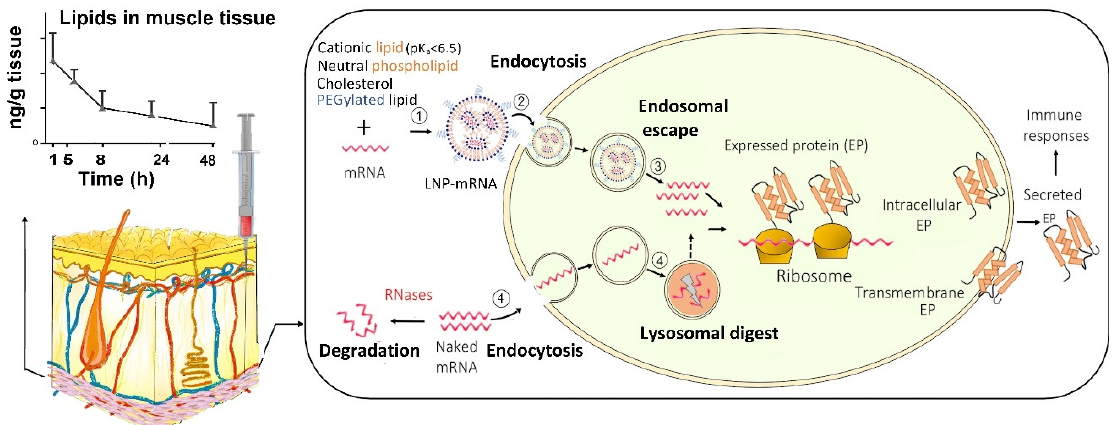
Figure 1. Uptake of mRNA-loaded lipid nanoparticles (LNPs) following intramuscular injection versus naked mRNA into the host cells and the subsequent intracellular trafficking. (1) mRNA is incorporated into LNP, which is assembled from cationic, neutral, and PEGylated lipids as well as cholesterol; (2) mRNA-loaded LNPs are internalised into the host cell; and (3) within the cell, mRNA-loaded LNPs undergo endosome escape, and release mRNA for protein synthesis. In contrast, (4) naked mRNA can be partially internalised, but the majority is degraded in lysosomes. In addition, the extracellular mRNA is cleaved by the ribonucleases (RNases) while LNPs at the injection site protect of mRNA from RNases. LNPs provide extended local tissue exposure and the pharmacokinetic profile depends on various factors such as the lipids used and particle size.